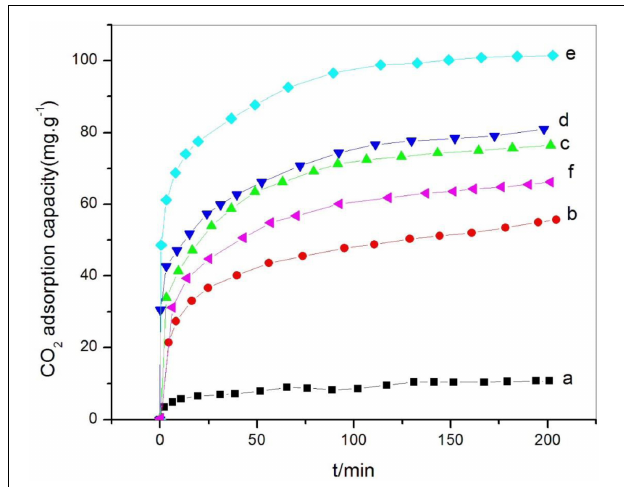
FIGURE 7 | CO 2 sorption capacities of pristine MMO before and after PEI loading: (a) pristine MMO; (b) MMO-PEI-30; (c) MMO-PEI-40; (d) MMO-PEI-50; (e) MMO-PEI-60 and (f) MMO-PEI-70 at 70 ◦